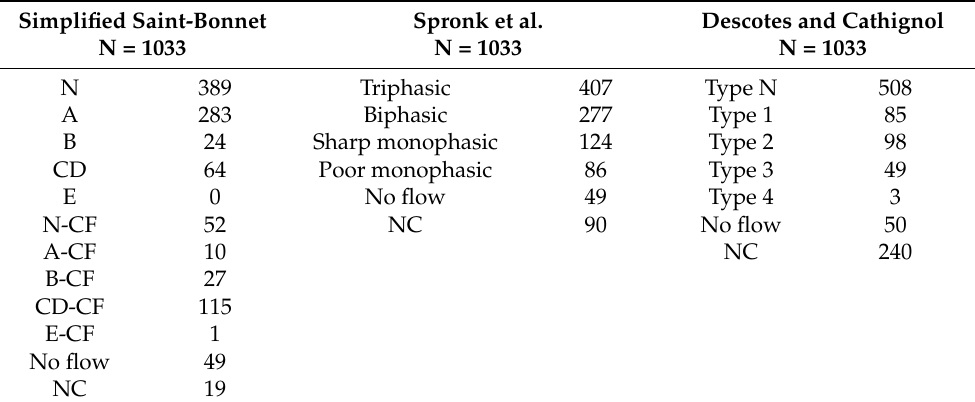
Table 2. Categorization details according to the Saint-Bonnet, Spronk et al. and Descotes and Cathignol